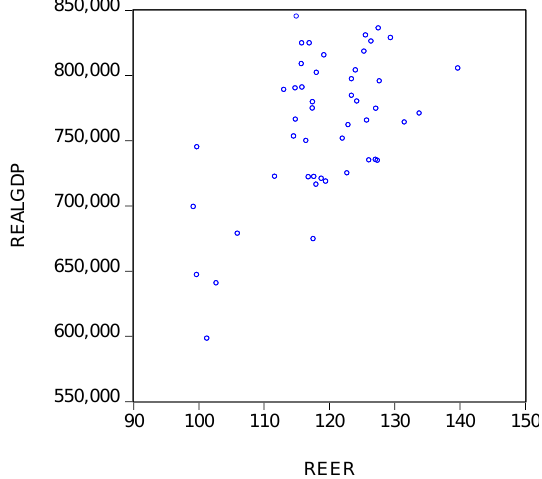
Figure 1: Scatter Diagram between Serbia’s Real GDP (REALGDP) and the Real Effective